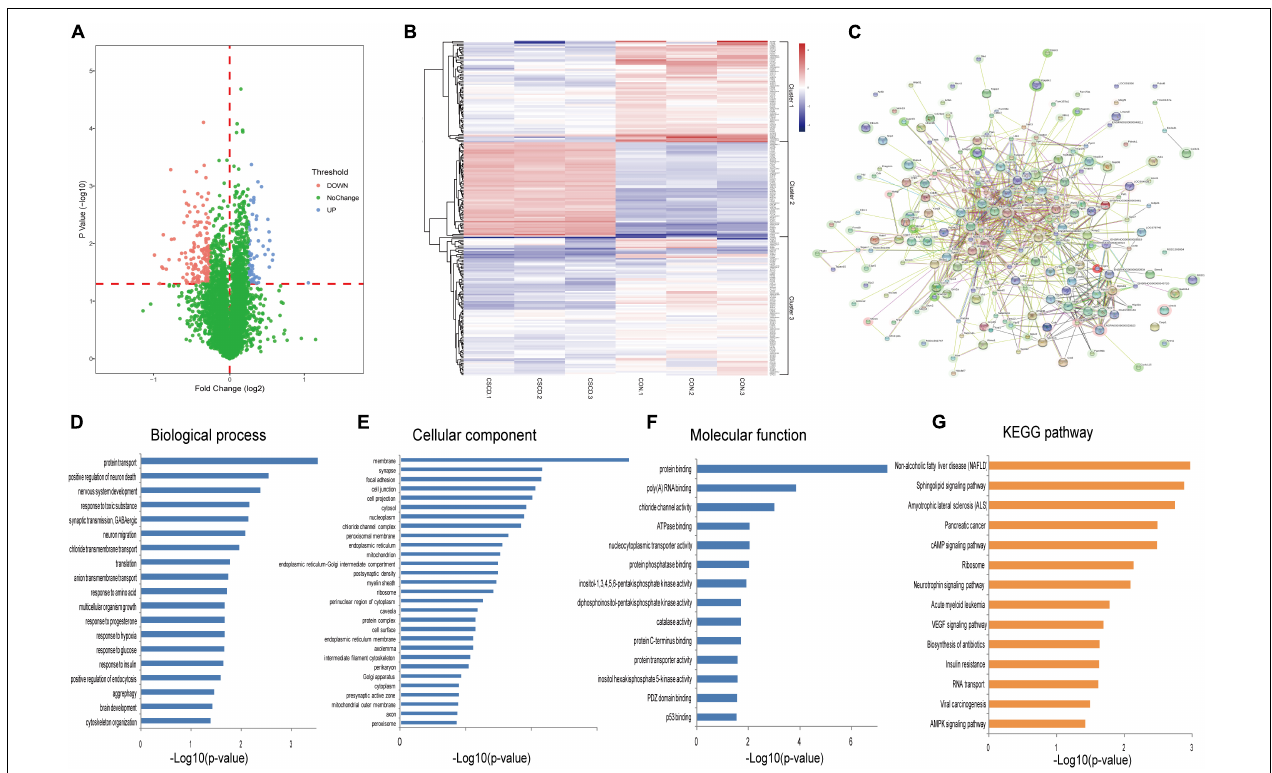
FIGURE 3 | Proteomic analysis of hippocampi from CSDS and CON groups rats. (A) Volcano plot of all proteins. (B) Heatmap of 234 differentially expressed proteins in the CSDS model: rows, proteins; columns, samples. (C) Protein-Protein interaction (PPI) network of 196 differently expressed proteins which was performed with STRING. Nodes represent proteins. Edges represent protein-protein associations. (D–F) Distribution of altered proteins for biological processes, cellular components, and molecular functions. Only GO terms that were significantly overrepresented ( p < 0.05) are shown. (G) Significantly enriched pathways identified by KEGG pathway analysis ( p <